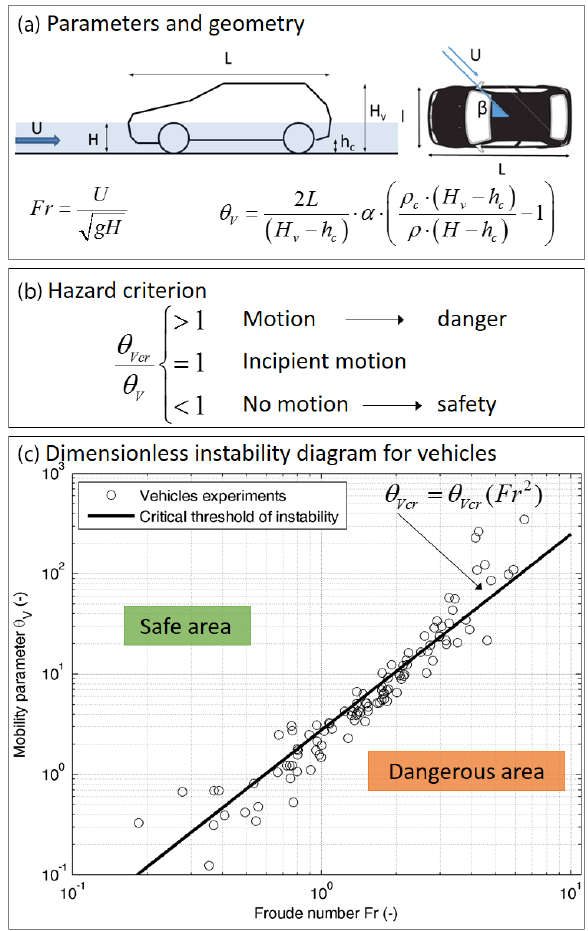
Figure 1. Sketch of the car geometry and definition of the mobility parameter (a) , definition of hazard criterion (b) and dimensionless instability diagram for flooded vehicles with identification of the critical threshold (c) (experimental data by Shu et al., 2011; Xia et al., 2011,